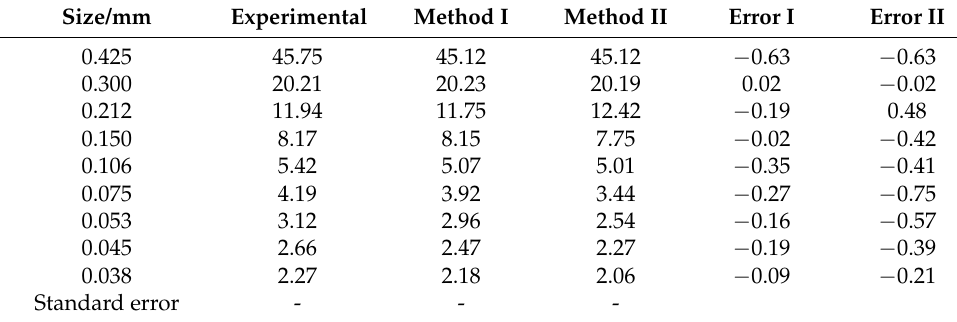
Table 8. The comparison of the simulation by two methods (grinding for 2 min). Size/mm Experimental Method I Method II Error I Error II